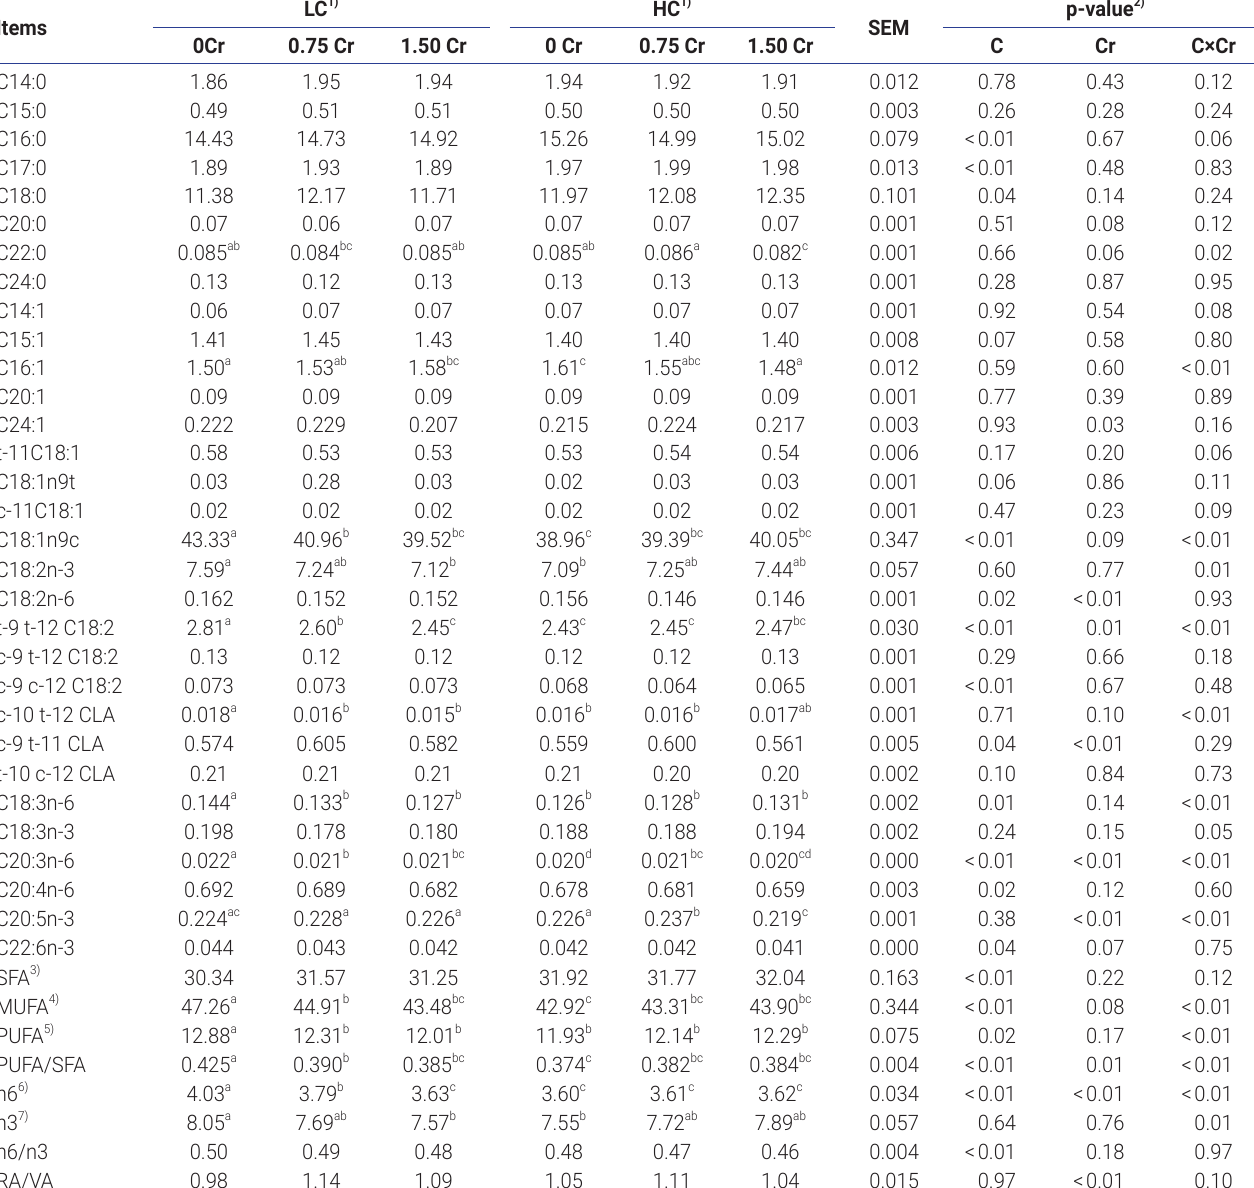
Table 8. Effects of concentrate level and Cr-Met supplementation on fatty acid composition (mg/g) of intramuscular fat of longissimus thoracis et lumborum in Tan